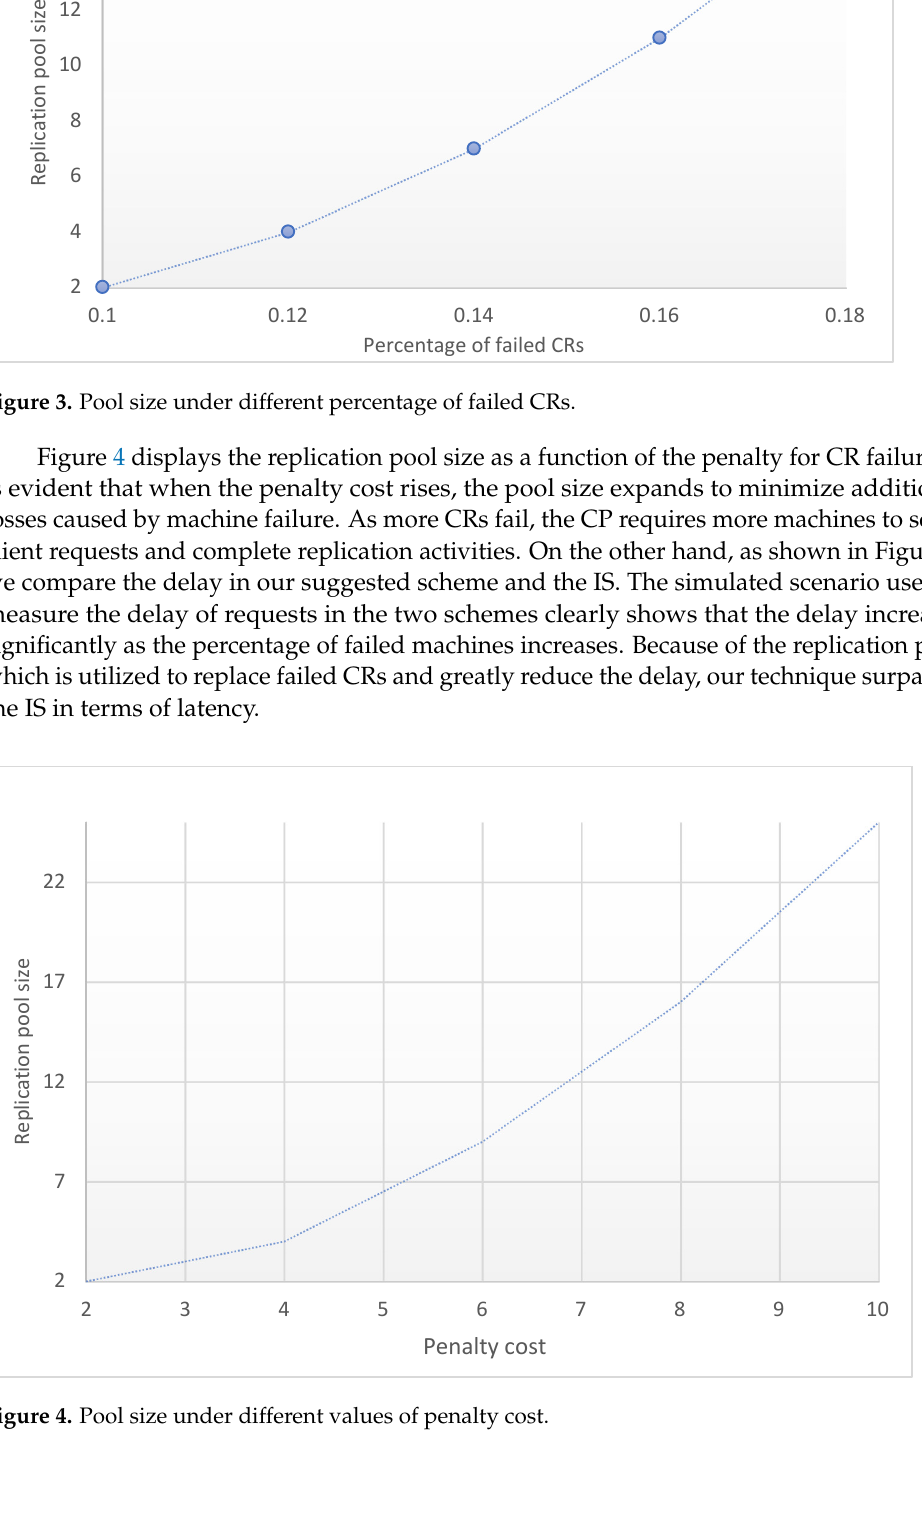
Figure 5. End-to-End delay under different percentage of failed CRs . 6. Conclusions and Future Work CP’s profit can be improved significantly by handling the QoS requirements of clients effectively. Because cloud services are prone to a range of failures, fault tolerance issues must be considered while developing new strategies to address all cloud market needs. In order to reduce resource waste while accommodating CR failure and increasing CSP profit, these strategies must strike a compromise between competing objectives. We proposed a new scheme that keep the services provided by the CP performing regardless of faults. In our scheme, the optimal number of CRs dedicated to replacing failed CRs is extracted. Newtown method is adopted for specifying the optimal size of replication pool. The proposed model moves the request into new CR for the pool of CRs if a machine fails to perform the task. This action minimizes the waiting time for clients and reduce the total migration time significantly. Current strategies for establishing fault